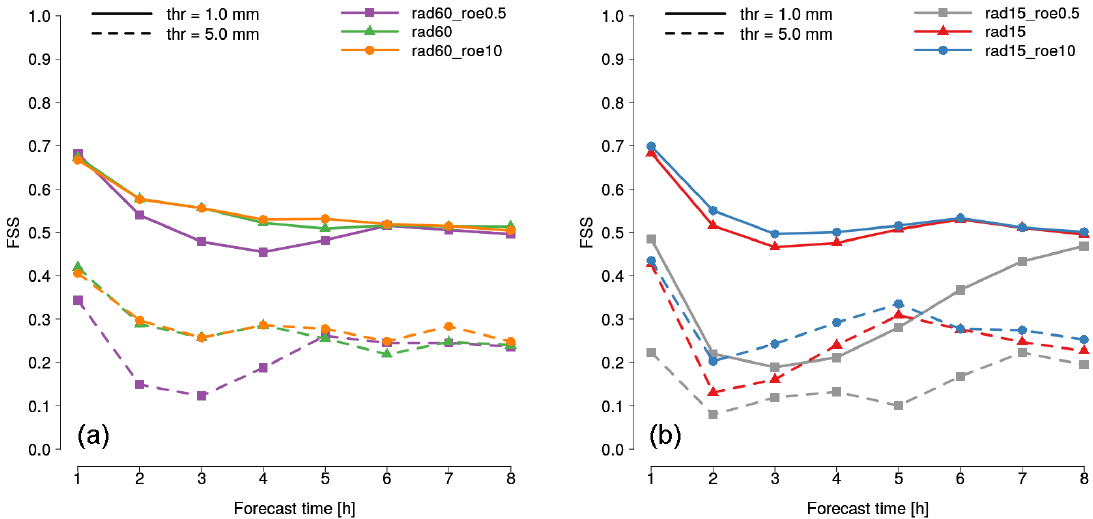
Figure 11. As in Fig. 6 but considering (a) experiments rad60_roe0.5 (violet), rad60 (green) and rad60_roe10 (orange), and (b) experiments rad15_roe0.5 (grey), rad15 (red) and rad15_roe0.5